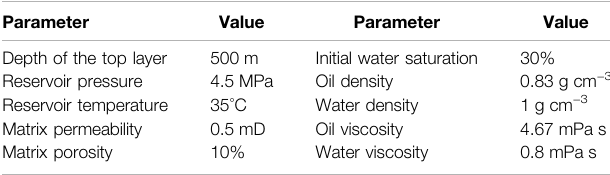
TABLE 2 | Reservoir parameters and production